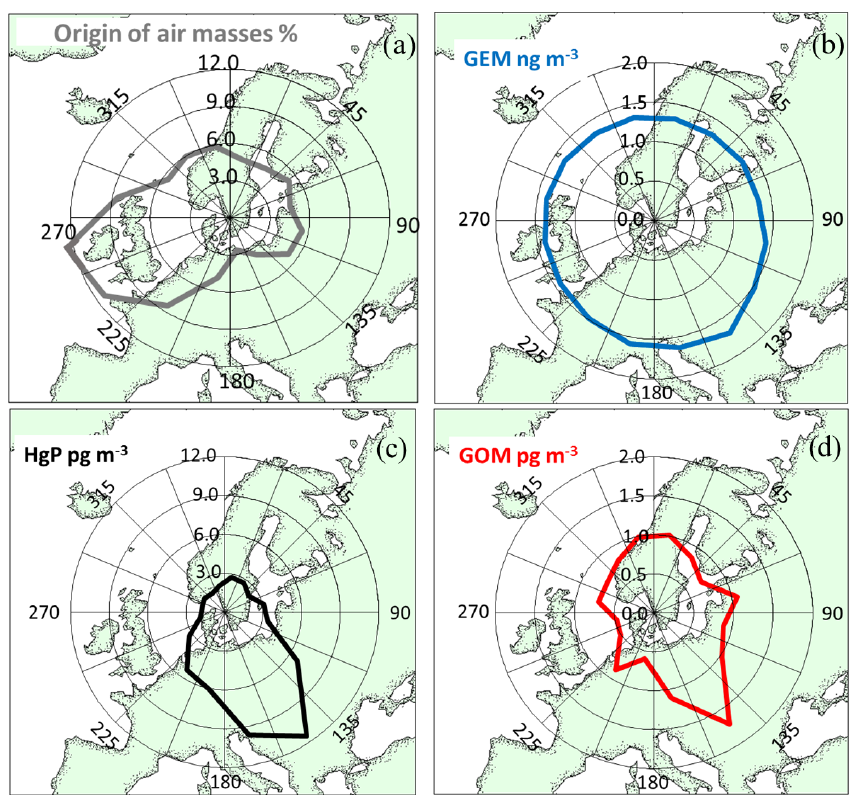
Figure 3. Results of the back-trajectory analysis. (a) Origin of air masses reaching the Råö site presented as relative frequency (%) within each sector. Panels (b) , (c) and (d) show GEM, PBM and GOM concentrations as a function of origin of air masses entering the measurement